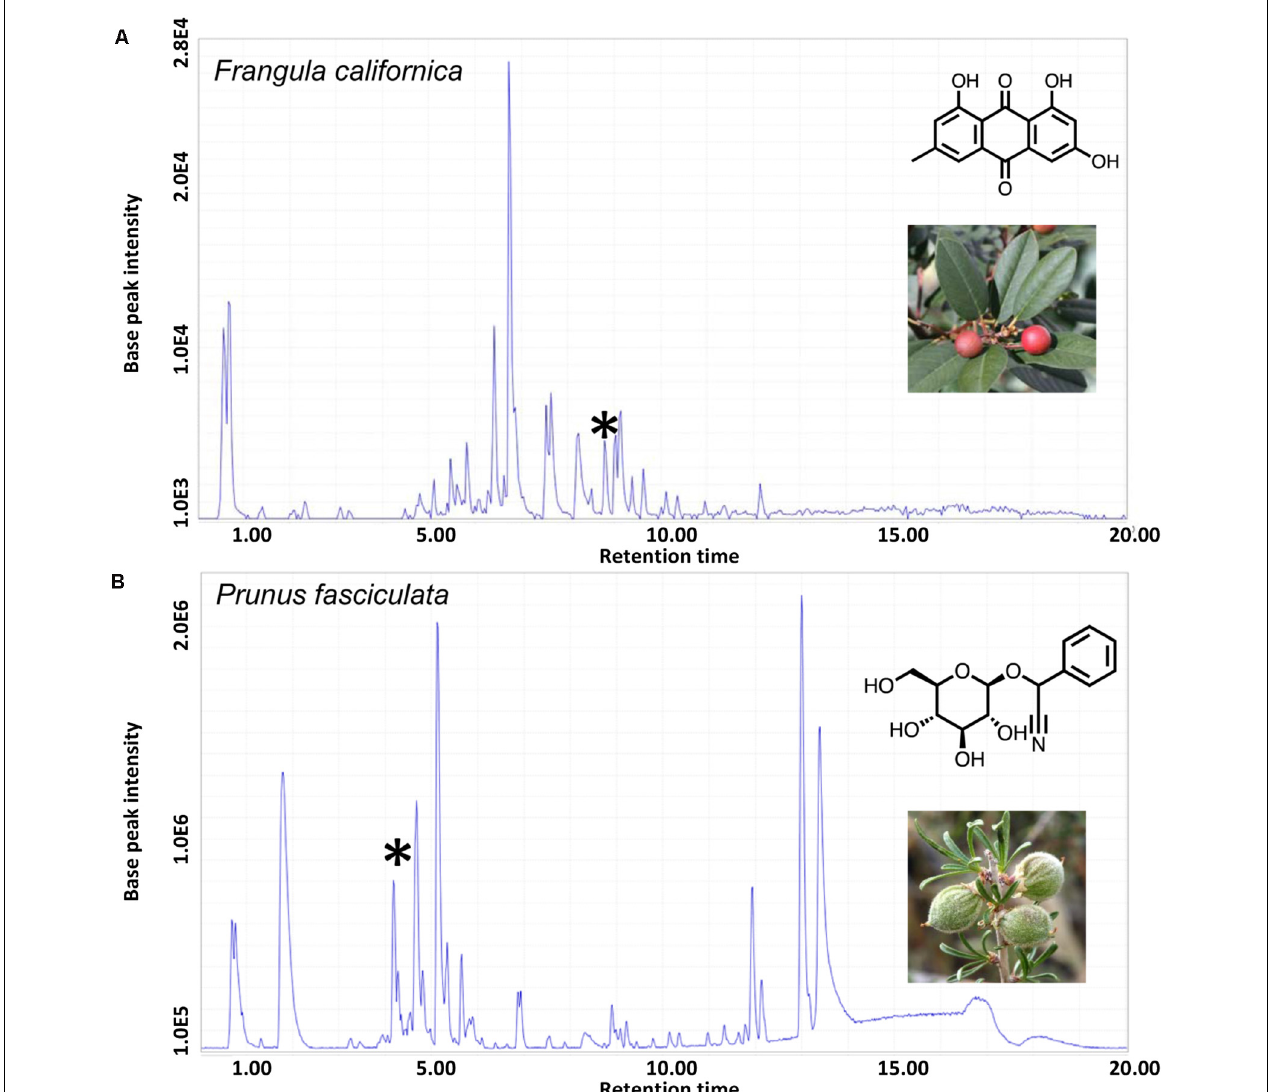
FIGURE 4 | HPLC-MS chromatograms of the dominant plant species in hill and flat diets, Frangula californica and Prunus fasciculata, respectively. (A) The asterisk indicates the chromatographic peak that corresponds to the anthraquinone, emodin. (B) The asterisk indicates the chromatographic peak that corresponds to the cyanogenic glycoside, prunasin. Mass spectrum of specified chromatographic peaks are available in Supplementary Table 2